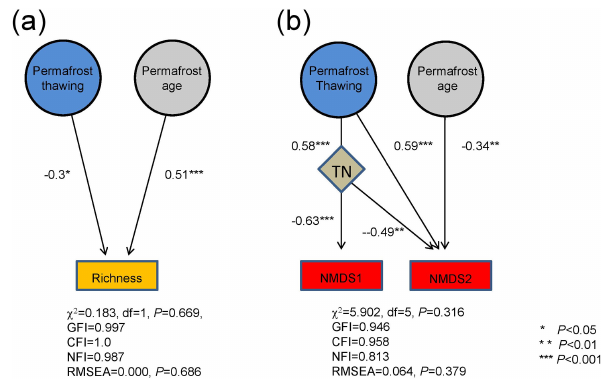
Figure 4. The relative importance of permafrost thawing status and age on bacterial richness (a) and community structure (b) based on structural equation modeling. The community structure variation was assessed by the first and second axis coordinates of the NMDS plot (NMDS1 and NMDS2). Numbers adjacent to arrows are the absolute values of the path coefficients, indicative of the standard- ized effect size of the relationship. ∗ : P < 0 . 05, ∗∗ : P < . 01, and ∗∗∗ : P < 0 .